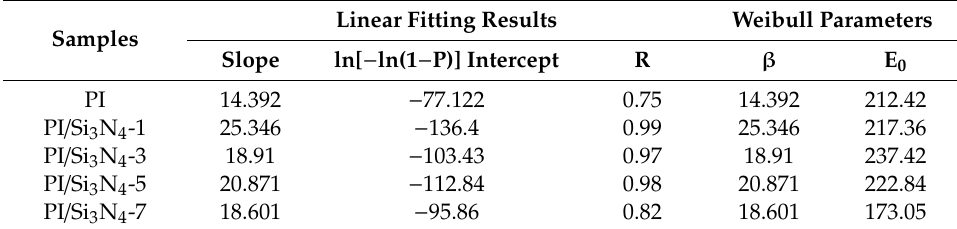
Table 2. Linear fitting results and Weibull parameters of PI composite films. Linear Fitting Samples